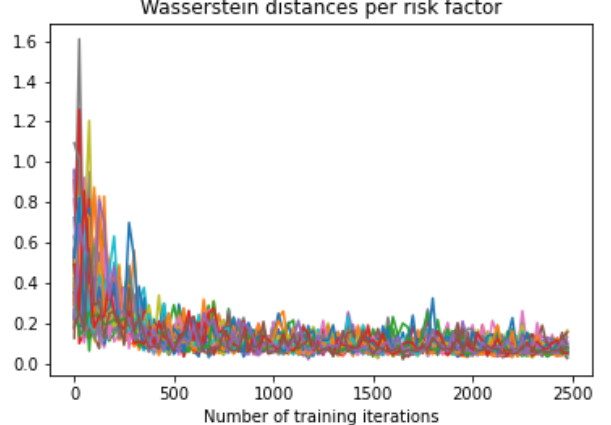
Figure 16. Development of the Wasserstein distances for all 46 risk factors during GAN training